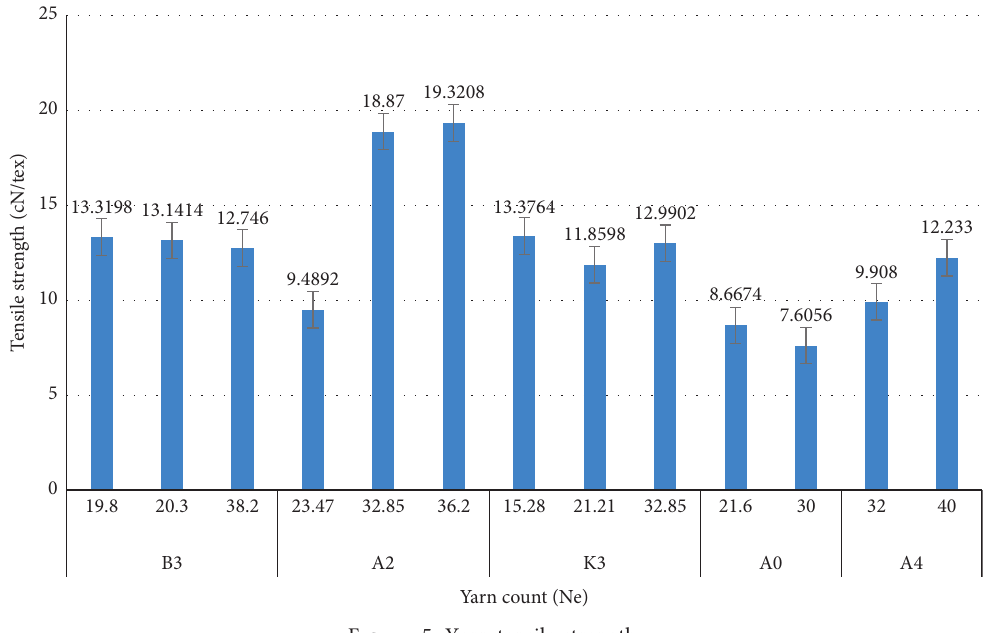
Figure 5: Yarn tensile strength.